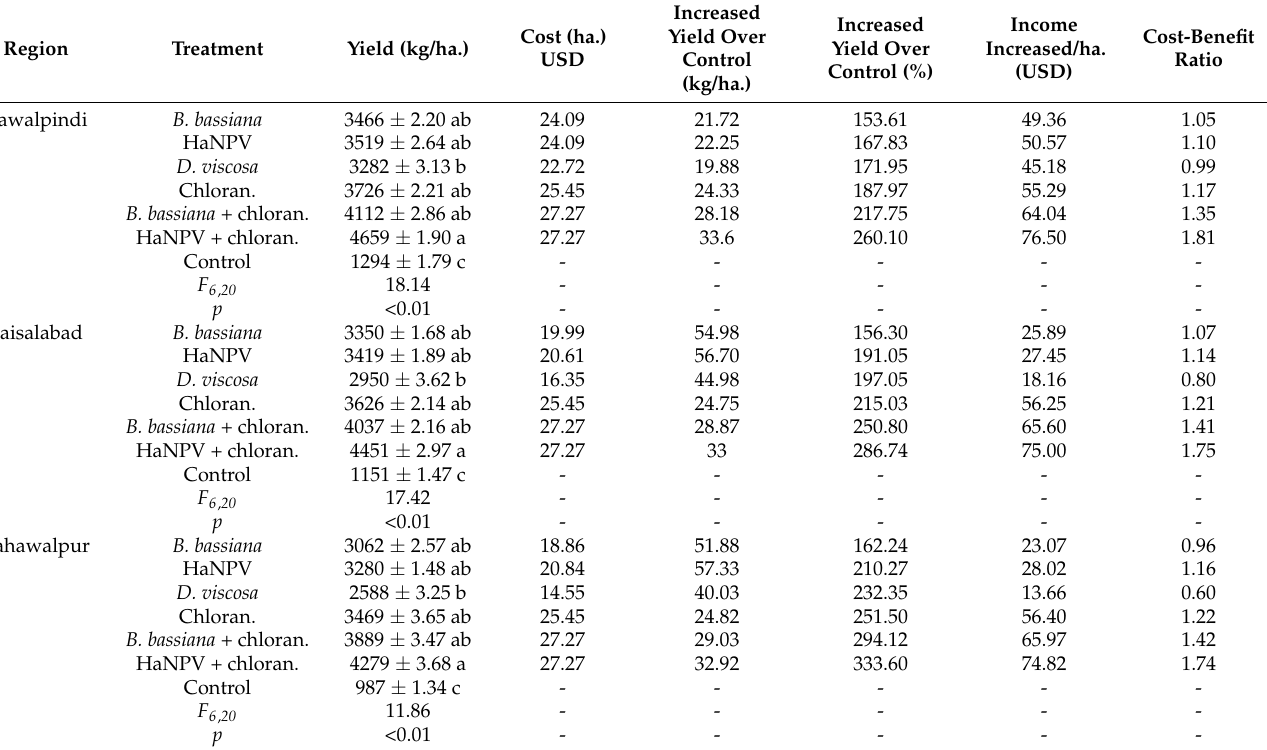
Table 5. Cost-benefit ratio of tomato crop after treating following field application of different biorational and chemical control options based on B. bassiana ; HaNPV; D. viscosa and chlorantranilip- role (chloran.). Yield means within each observation that are followed by the same letters are not significantly different from each other; Tukey-Kramer HSD test at p = 0.05.